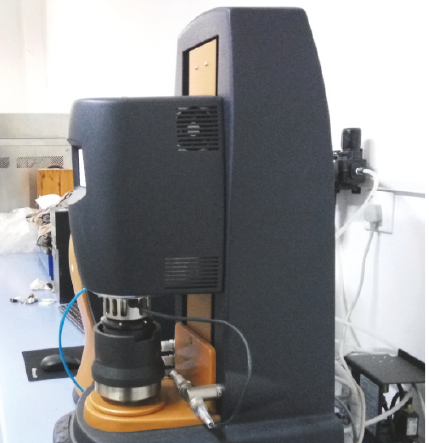
Figure 2: The dynamic-shear